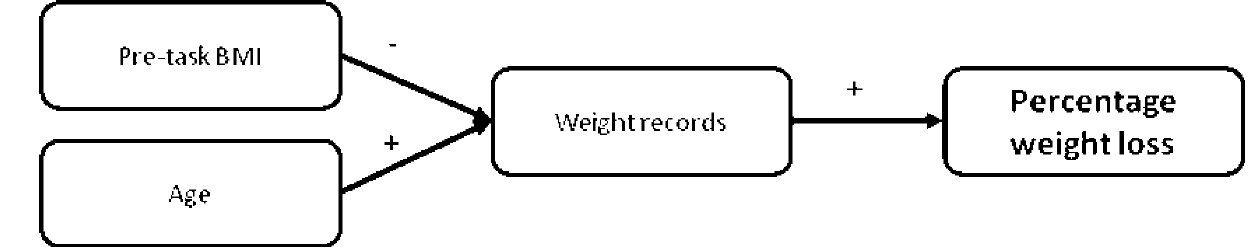
Figure 4. Combined model for variables predicting percentage weight loss.